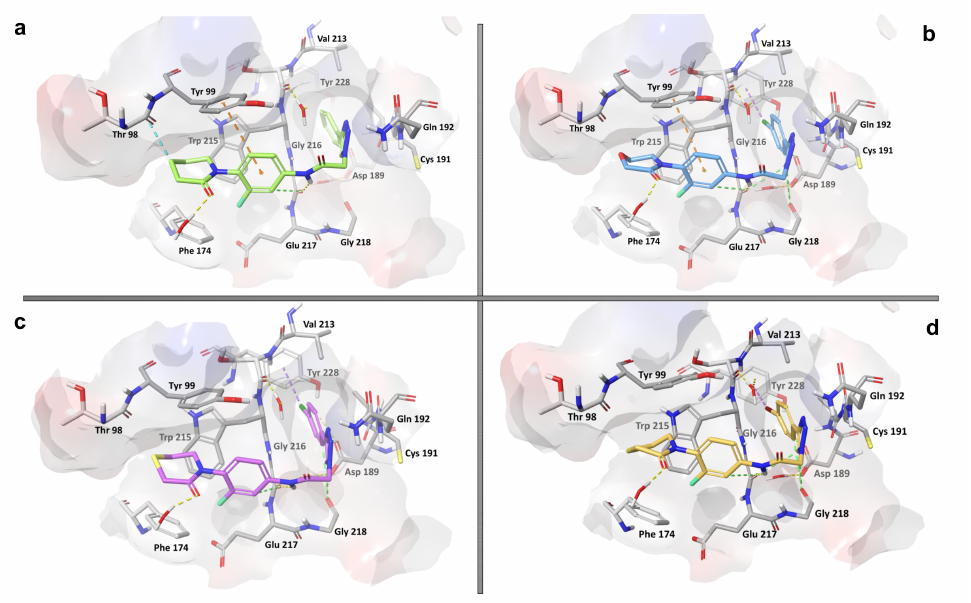
Figure 4. Molecular docking poses of active peptide-1,2,3-triazole derivatives 8a, 8k, 8l and 8p ( a – d ) into the active site of the FXa enzyme (PDB: 2P16). The dotted lines indicate the most common ligand–protein interactions: H bonds in yellow, π – π stackings in orange, halogen– π interactions in magenta and aromatic H bonds in